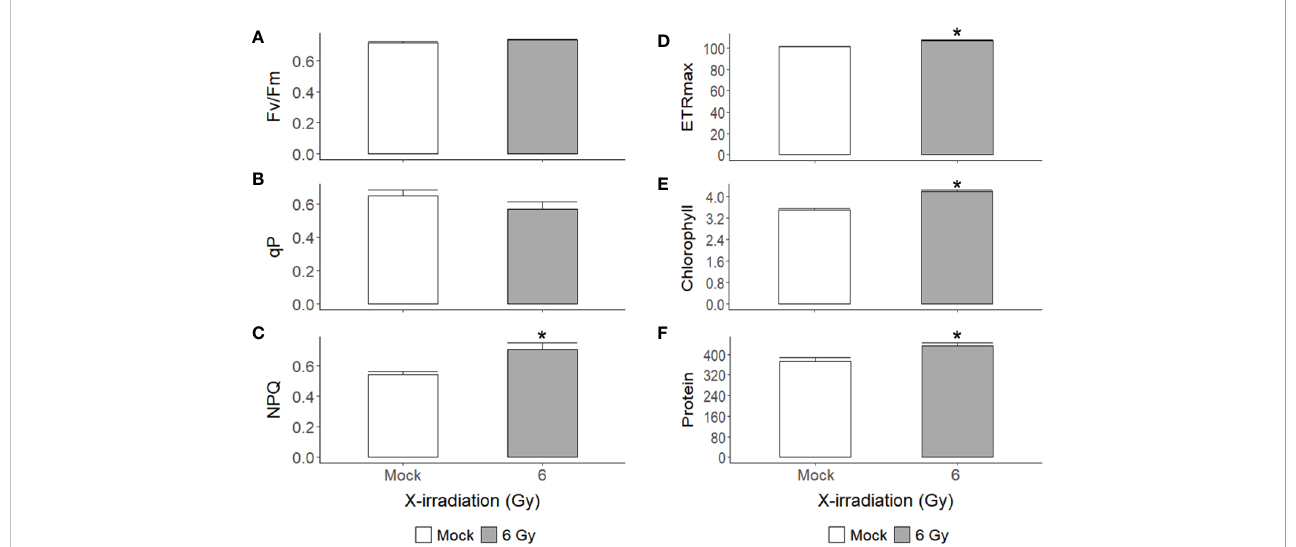
FIGURE 6 Changes in photosynthetic activity, chlorophyll, and protein contents of C. reinhardtii cells after repetitive X-irradiation with 6 Gy. (A – D) The chlorophyll fl uorescence and quenching parameters Fv/Fm, qP, NPQ, and the maximal electron transport rate ETRmax were obtained and used to evaluate the photosynthetic activity of C. reinhardtii cells as described in the Materials and Methods section. (E, F) The chlorophyll and protein contents ( m g) of C. reinhardtii cells (10 8 ). Data represent the mean ± standard error (SE) with n = 9 from three independent experiments. Asterisks indicate signi fi cant differences between mock (white bars) and irradiated samples (gray bars) based on a two-sample independent t -test ( p < 0.05).